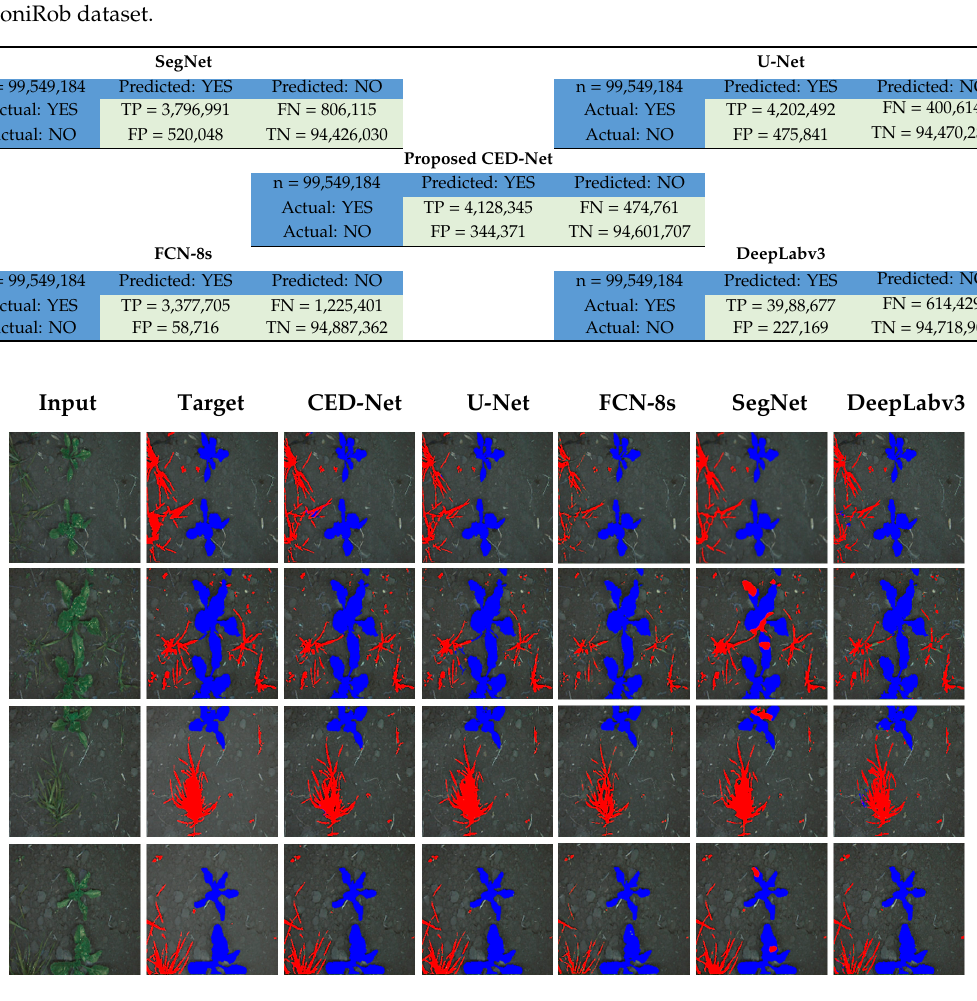
Figure 5. Semantic segmentation results for BoniRob dataset. Table 6. Confusion matrices of SegNet, U-Net, FCN-8s, DeepLabv3, and proposed CED-Net for BoniRob dataset.